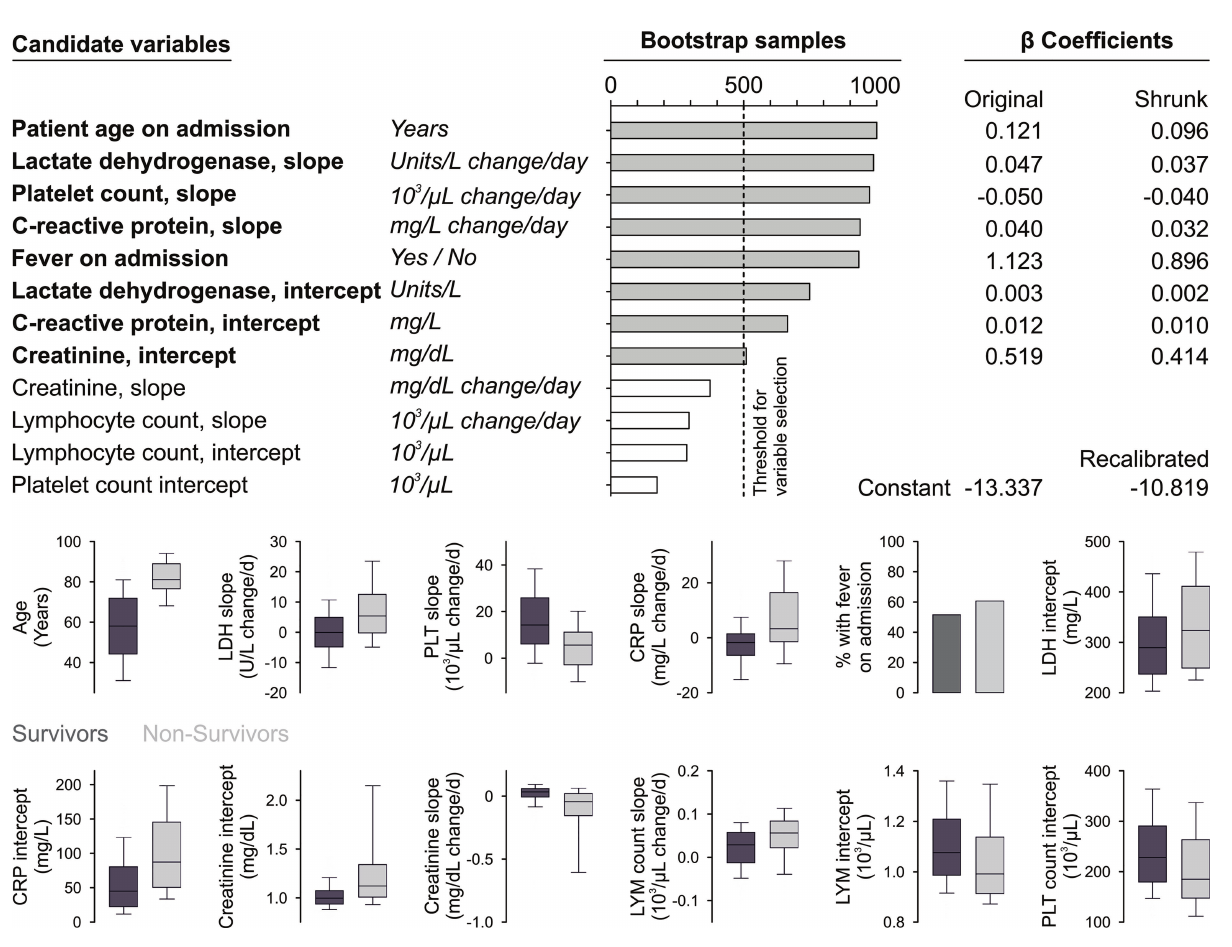
FIGURE 2 | Model development. Candidate variables in bold were selected as they remained in the model after backward elimination in more than 50% of all bootstrap samples. Coef fi cients were shrunk according to a linear shrinkage factor, which was 0.7974 (Steyerberg et al., 2001). The constant was recalibrated that the mean estimated mortality probability corresponded to the mortality in the training sample. The boxplots show median, interquartile range as well as 10 th and 90 th percentile of continuous candidate variables or percentages for fever on admission according to